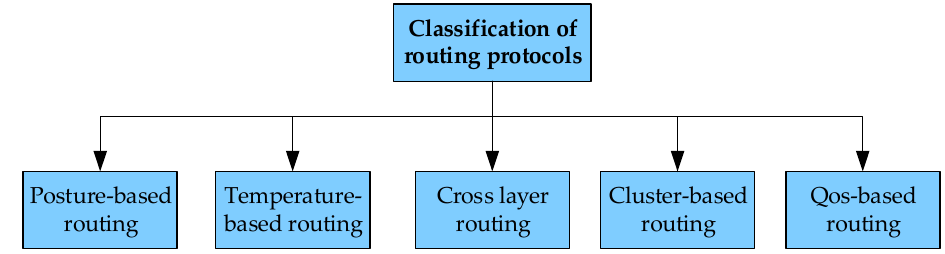
Figure 3. Routing classification for wireless body area networks.